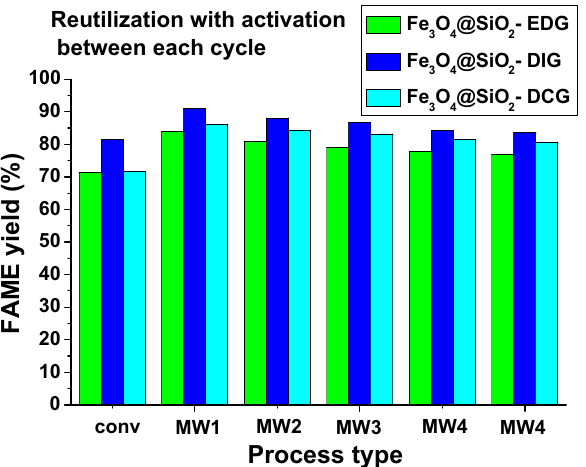
Figure 7. FAME yield for the recycling experiments for the magnetic catalysts with an activation stage between each cycle (activation before each reaction; temperature 80 ºC; reaction time 180 min; molar ratio oil/MeOH 1/6; 3.5% weight ratio catalyst vs. oil; 780 rpm).